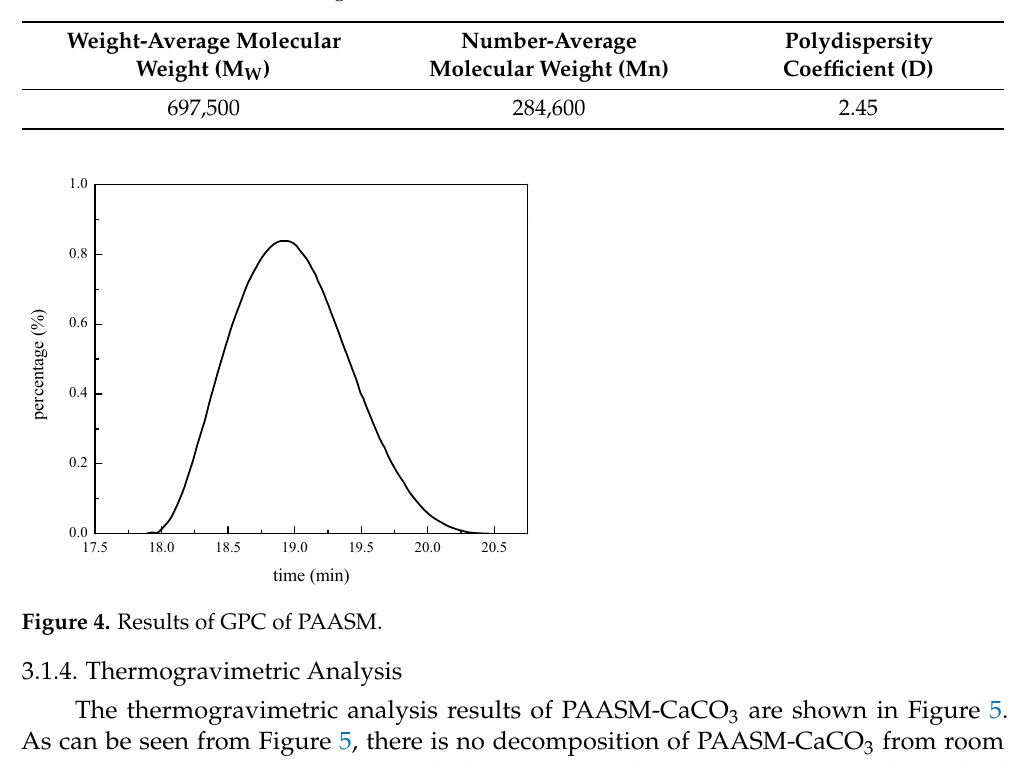
Table 2. Surface hydroxyl number test of NCC before and after modification.